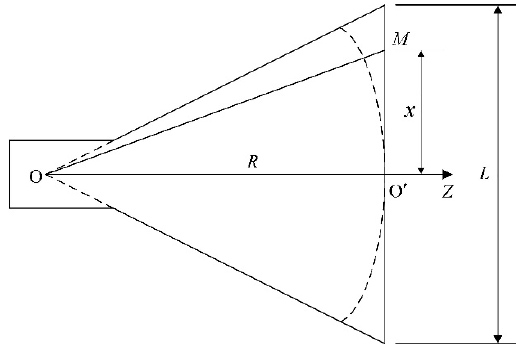
Figure 2. Cross section of the H ‐ plane sectoral horn antenna.